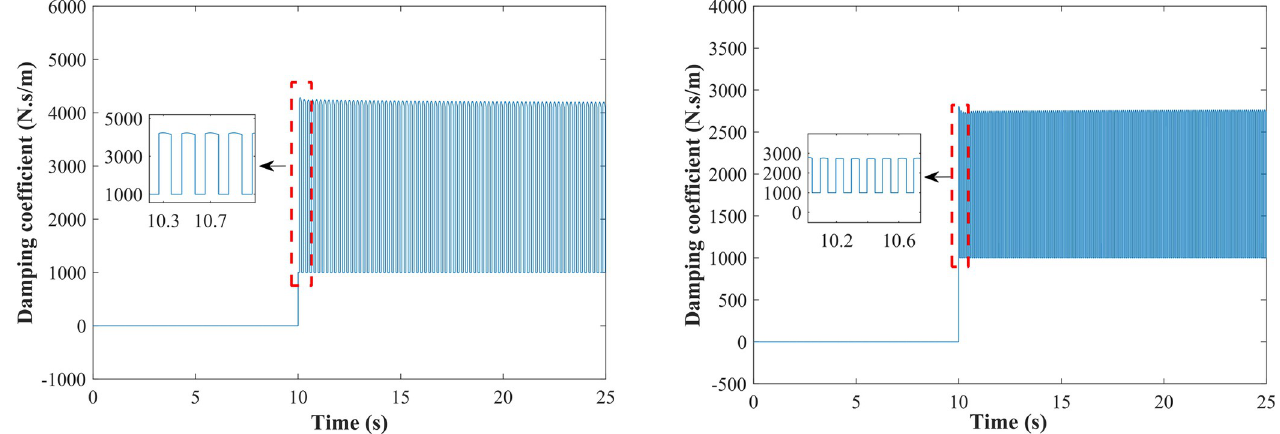
Fig 16. Damping coefficient of the damping-adjustable damper from median to high mode. (A) f = 5 Hz.; (B) f = 10 Hz.